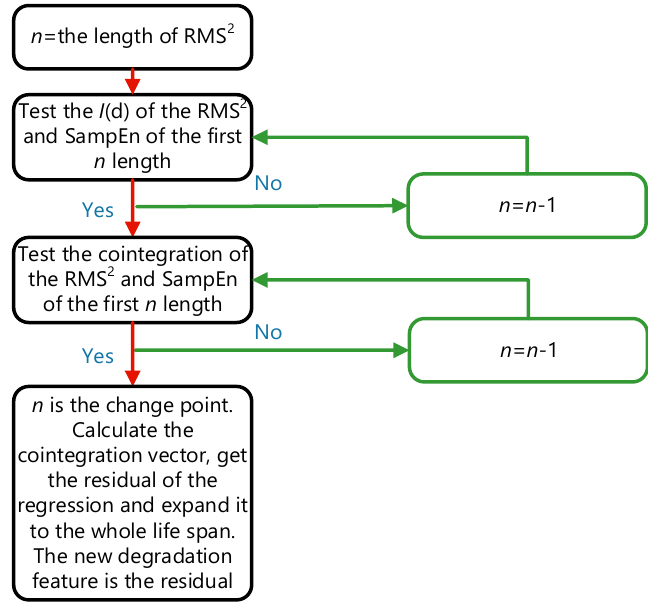
Figure 13. The flow chart of extraction of the new degradation feature.